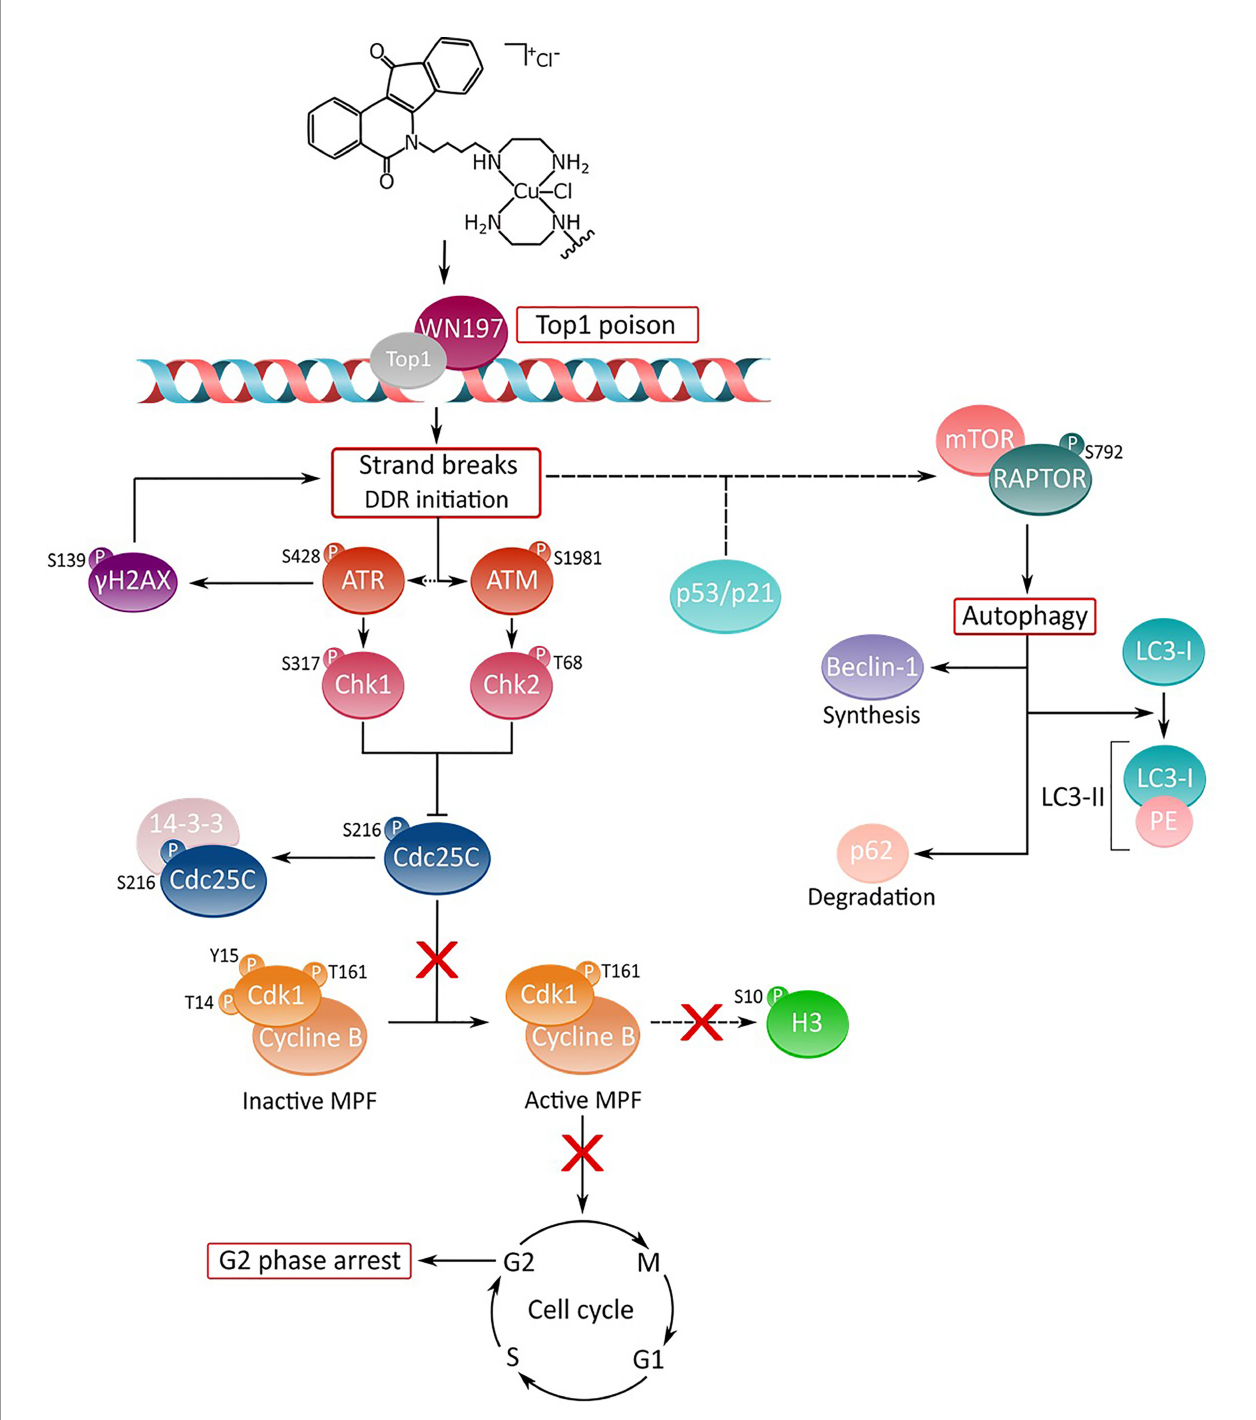
FIGURE 8 | Deciphering of the molecular mechanisms of the novel copper(II) indenoisoquinoline complex WN197. WN197 inhibits topoisomerases I at low doses in a poison mode and forms a ternary complex with the topoisomerase and DNA, leading to strand breaks accumulation. Phosphorylated H2AX ( g H2AX) localizes at the sites of DNA damage. The DNA damage response pathway is activated: ATM and ATR kinases are phosphorylated, and subsequently activate Chk1 and Chk2, leading to Cdc25C phosphorylation on serine 216 (S216), and to its binding to 14-3-3. Consequently, Cdk1 remains phosphorylated on tyrosine 15 (Y15), impeding the activation of the MPF (Cdk1/Cyclin B) and the phosphorylation of H3 on serine 10 (S10). Cancer cells arrest in the G2 phase of the cell cycle. The DDR also leads to an increase in p53 and p21 followed by an autophagic cell death characterized by the phosphorylation of RAPTOR on serine 792 (S792) in the mTORC1 complex, the synthesis of Beclin-1, the formation of LC3-II (complex LC3-I/PE (phosphatidylethanolamine)), and the degradation of p62.